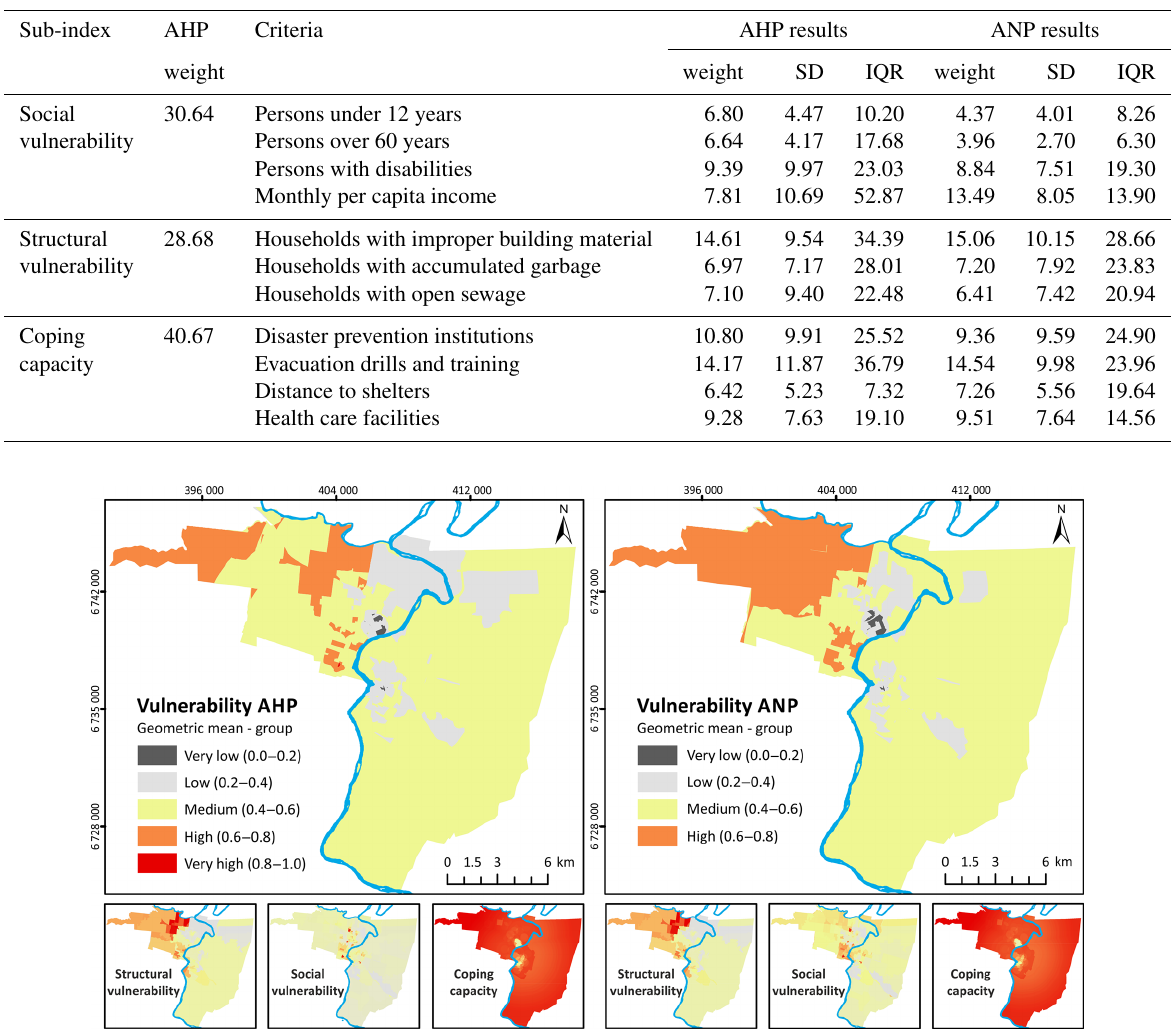
Figure 5. Spatial distribution of flood vulnerability in the study